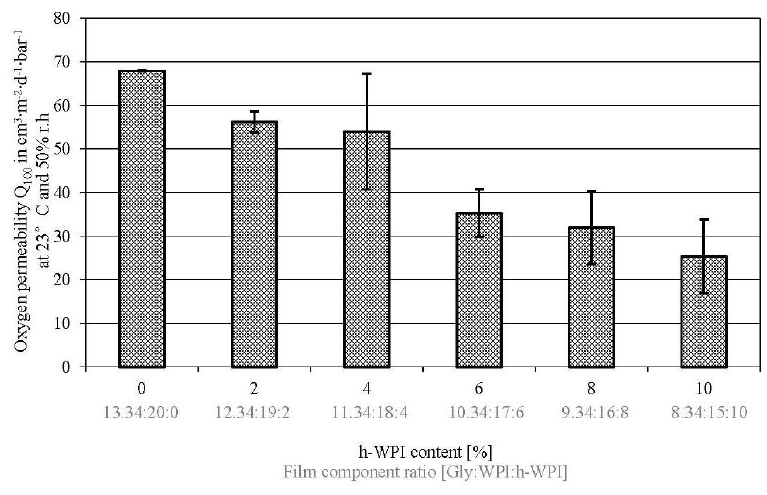
Figure 3. Effect of increased h-WPI content (reduced protein M content on the oxygen permeability of WPI-based